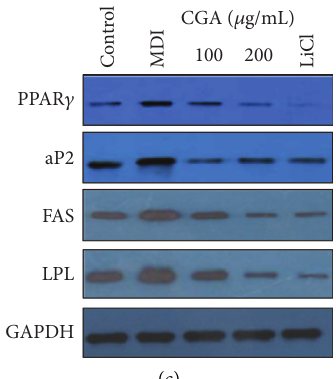
Figure 5: Effects of chlorogenic acid on the expression of transcription factors and genes associated with adipogenesis in 3T3-L1 cells. (a, b) Protein expression of PPAR- c , aP2, FAS, and LPL by Western blot analyses. Data are presented as means ± SE from three independent experiments. ∗ P < 0 . 05, ∗∗ P < 0 . 01. (c) Effects of CGA on gene expression of PPAR- c , aP2, FAS, and LPL in 3T3-L1 cells. Data are presented as means ± SE from three independent experiments. ∗ P < 0 . 05, ∗∗ P < 0 .